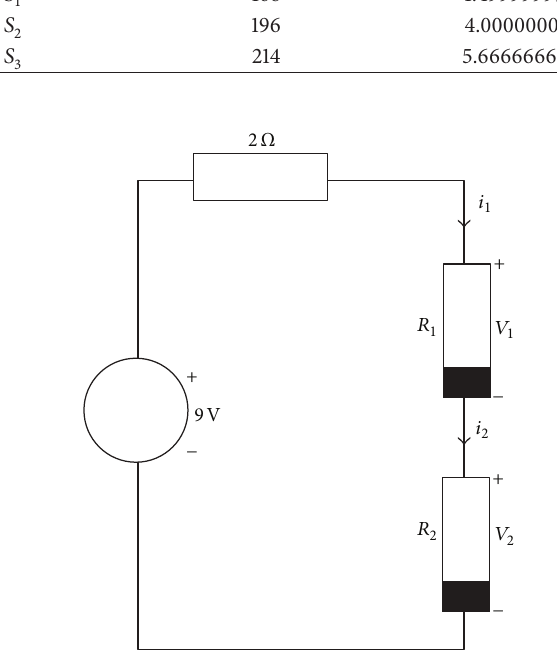
Figure 4: Two nonlinear resistor